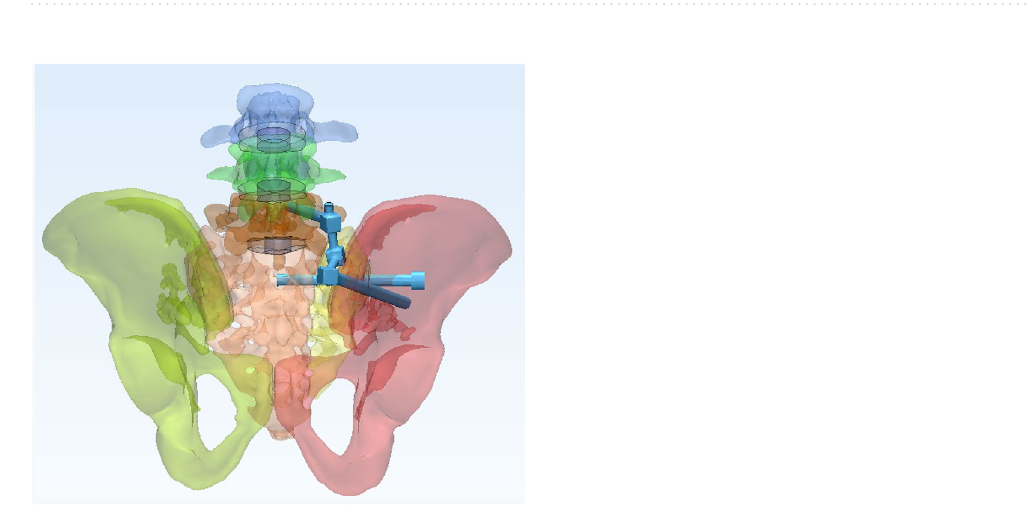
Figure 6. Sketch map of L5NS1 (created by Mimics17.0 https:// www. mater ialise. com/ en/ healt hcare/ elect ronic- instr uctio ns- for- use/ mimics- resea